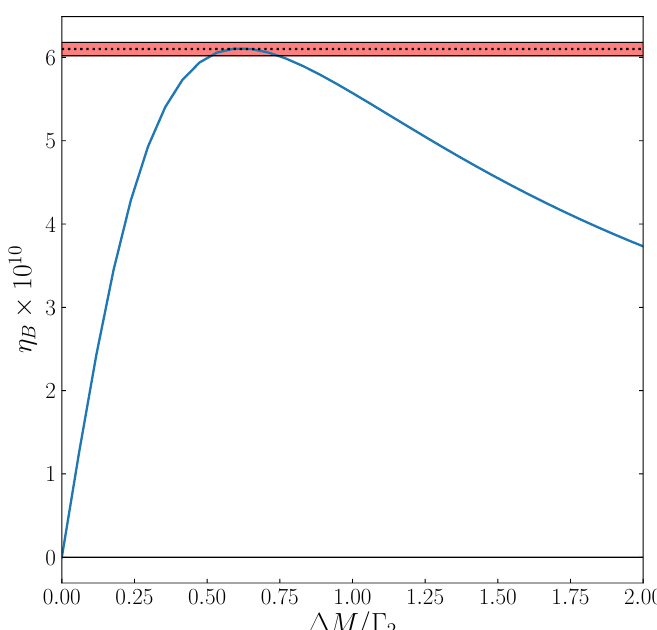
Figure 2 . The baryon asymmetry as a function of the heavy Majorana neutrino mass splitting divided by the decay rate of N 2 at the lower-bound of M for successful leptogenesis in the Neutrino Option. The plots take an identical form for both normal ordering (for which (cid:0) 2 = 1 : 62 10 (cid:0) 2 GeV) (cid:2) and inverted ordering (for which (cid:0) 2 = 8 : 63 10 (cid:0) 3 (cid:2)